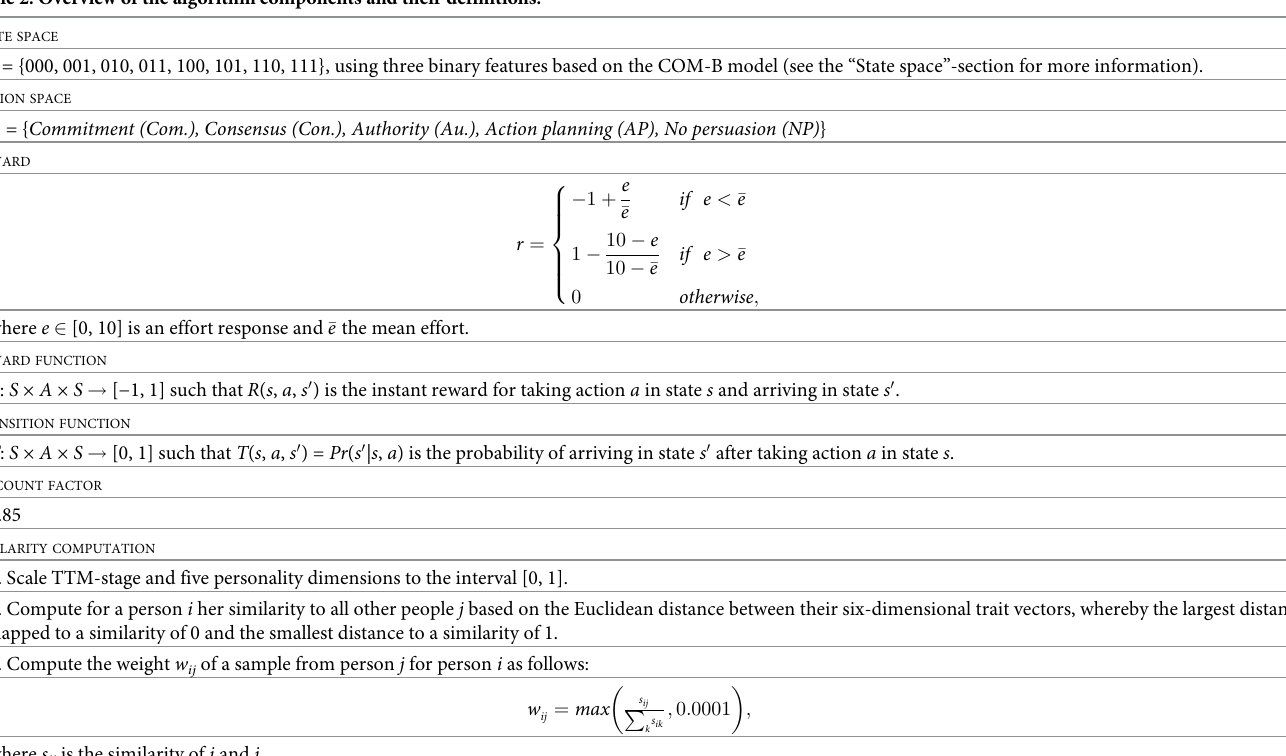
Table 2. Overview of the algorithm components and their